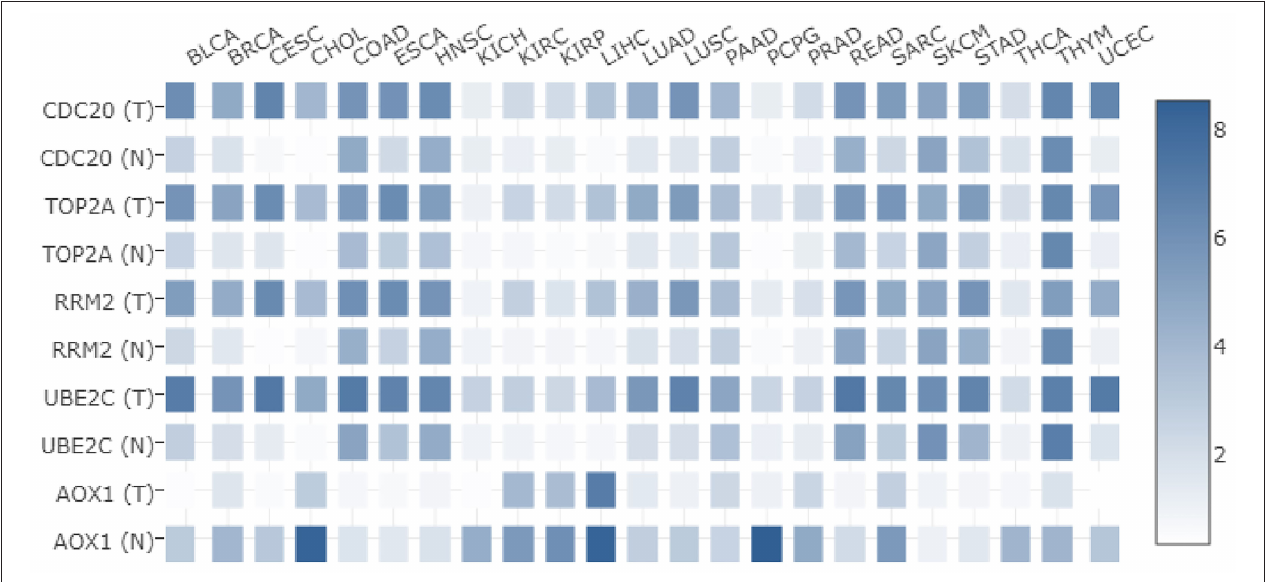
Frontiers in Medicine |